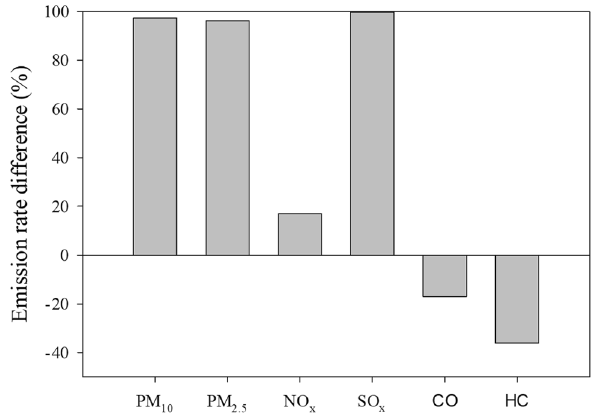
Figure 4. The emission rate differences of air pollutants from the ship while using ULSFO and HFO in the inter ports. ULSFO was used in the West Coast region while HFO was used in East Asia. Equation (3) was used for calculating the difference.